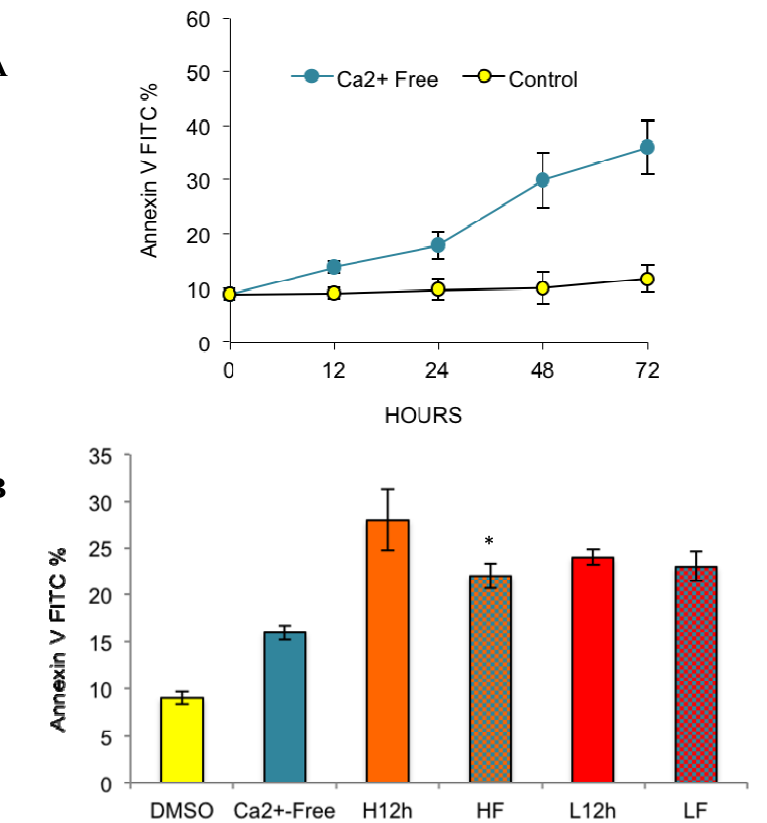
Figure 4. Effects of Ca 2+ free medium on paclitaxel-induced apoptosis. Total apoptosis level was measured by Annexin V-FITC assay. ( A ) is total apoptosis induced by Ca 2+